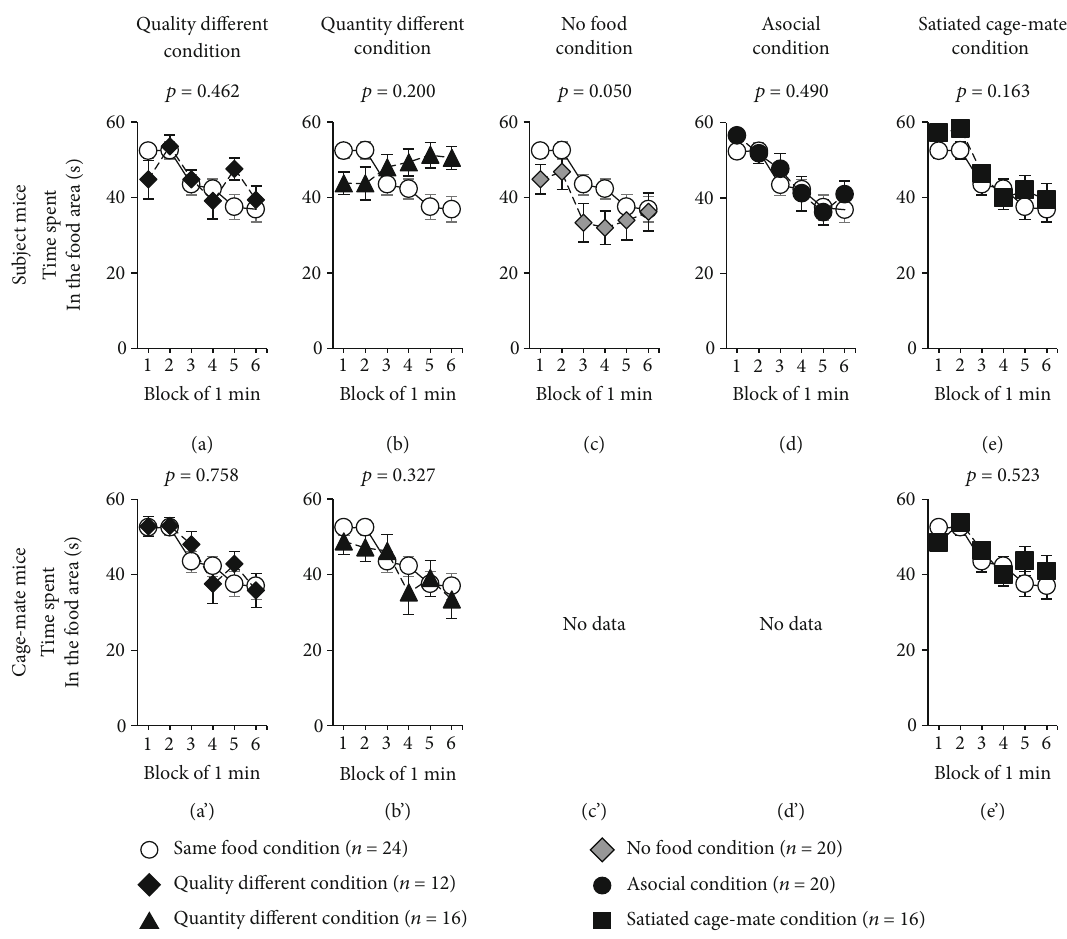
Figure 3: Comparison of the time spent per 1-minute in the food area. Comparison of the time spent in the food area in each 1-minute period in various conditions of the feeding behavioral test (same food condition, n = 24 ; quality di ff erent condition, n = 12 ; quantity di ff erent condition, n = 16 ; no food condition, n = 20 ; asocial condition, n = 20 ; stu ff ed cage-mate condition, n = 16 ). The upper row shows the subject mice ((a) – (e)), and the lower row shows the cage-mate mice ((a ′ ) – (e ′ )). Data are presented as means ± SEM . Statistical signi fi cance is represented by asterisks: ∗ p < 0 : 05 . The p values were calculated by a two-way repeated measures